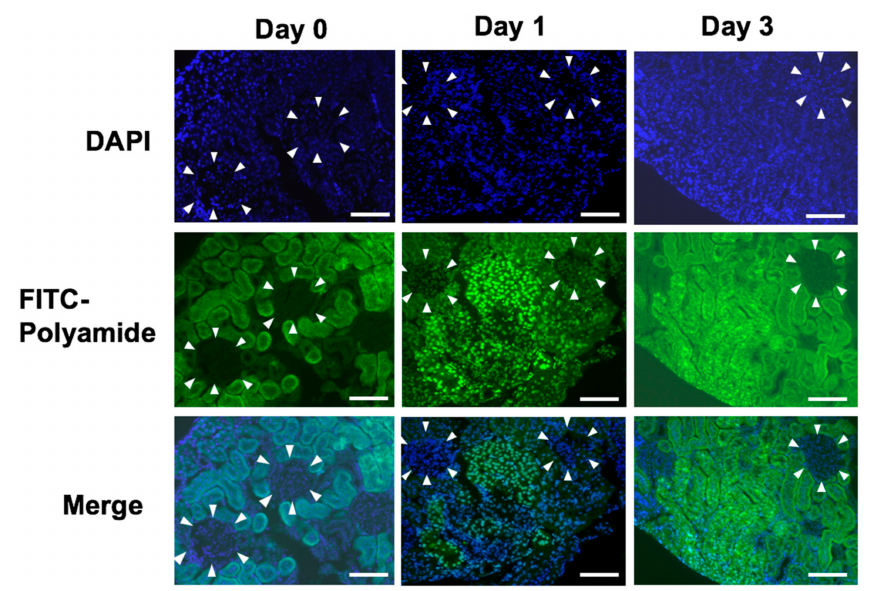
Figure 5. Delivery of USF1 pyrrole-imidazole (PI) polyamide in rat kidney. One milligram of FITC- USF1 PI polyamide-3 was injected intraperitoneally into Wistar rats. After 1 (Day 1) and 3 days (Day 3), the kidneys were removed, and frozen specimens were prepared and viewed. The scale bar indicates 25 µ m. The arrow heads distinguish the glomerulus from